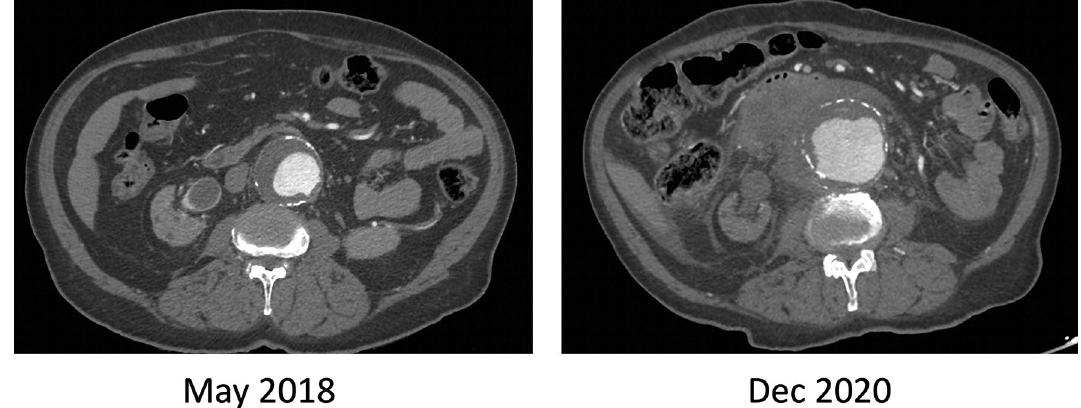
Fig. 2 CT scan with contrast comparing 2017 and 2020 showed marked expansion of abdominal aortic aneurysm with evidence of retroperito- neal